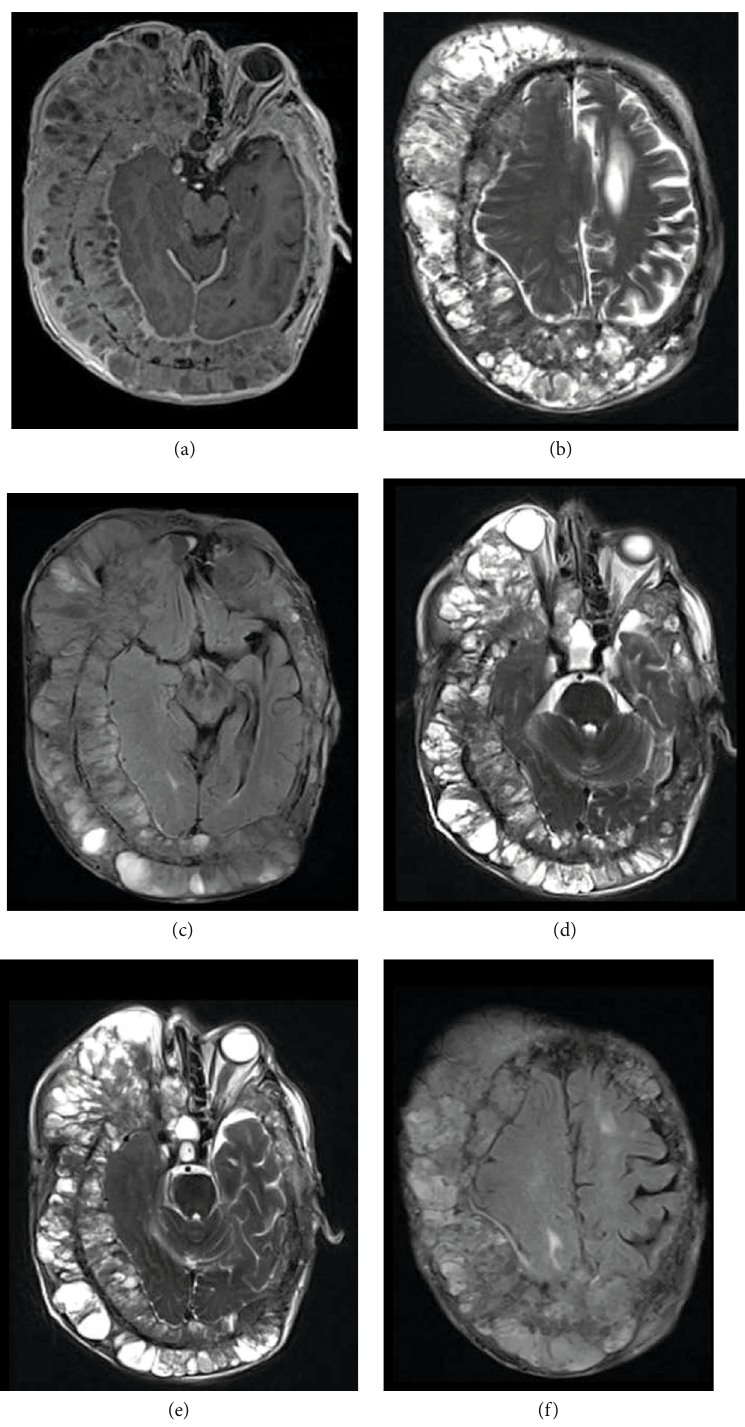
Figure 2: 3.0T MRI with and without administration of paramagnetic contrast agent. On axial postgadolinium T1w-FFE image, there is evidence of (a) an extensive enhancing lesion of the scalp showing, in axial T2-TSE images, in fi ltration of (b) skin, bones, dura mater, and subdural spaces at the level of the right middle and inferior frontal gyrus. Compression of the right orbital and straight gyrus is also noted, as seen on axial FLAIR-T2w images (c). Axial T2-TSE images show also that (d) the right orbit is fully invaded by the lesion, with proptosis of the globe, which appears compressed, and compression of the optic nerve and that (e) there is invasion of ethmoidal cells, pterygopalatine fossa, and foramen rotundum. Axial FLAIR-T2w images show elevated signal intensity in some white matter fi bers, like the right frontal lobe